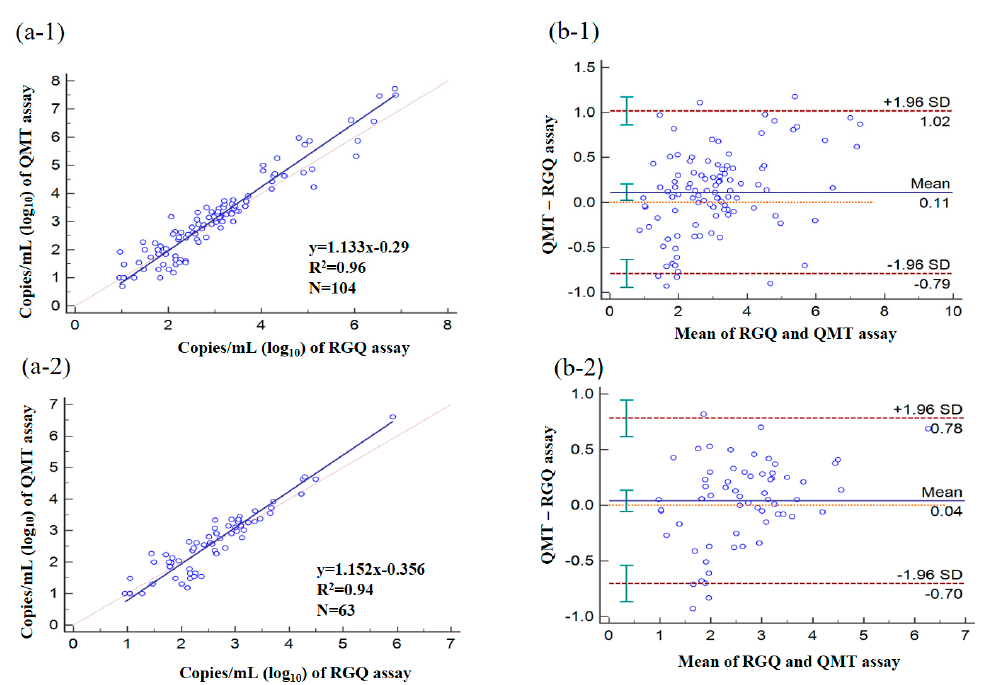
Figure 2. Quantitative analysis of clinical specimens using RGQ and QMT assays. Deming regression and Pearson correlation ( a ), and Bland–Altman analysis ( b ) of the RGQ and QMT assays. CMV DNA load (log 10 IU / mL) determined for positive samples among all tested specimens ( − 1, n = 104) and plasma specimens ( − 2, n = 63) tested by both assays.